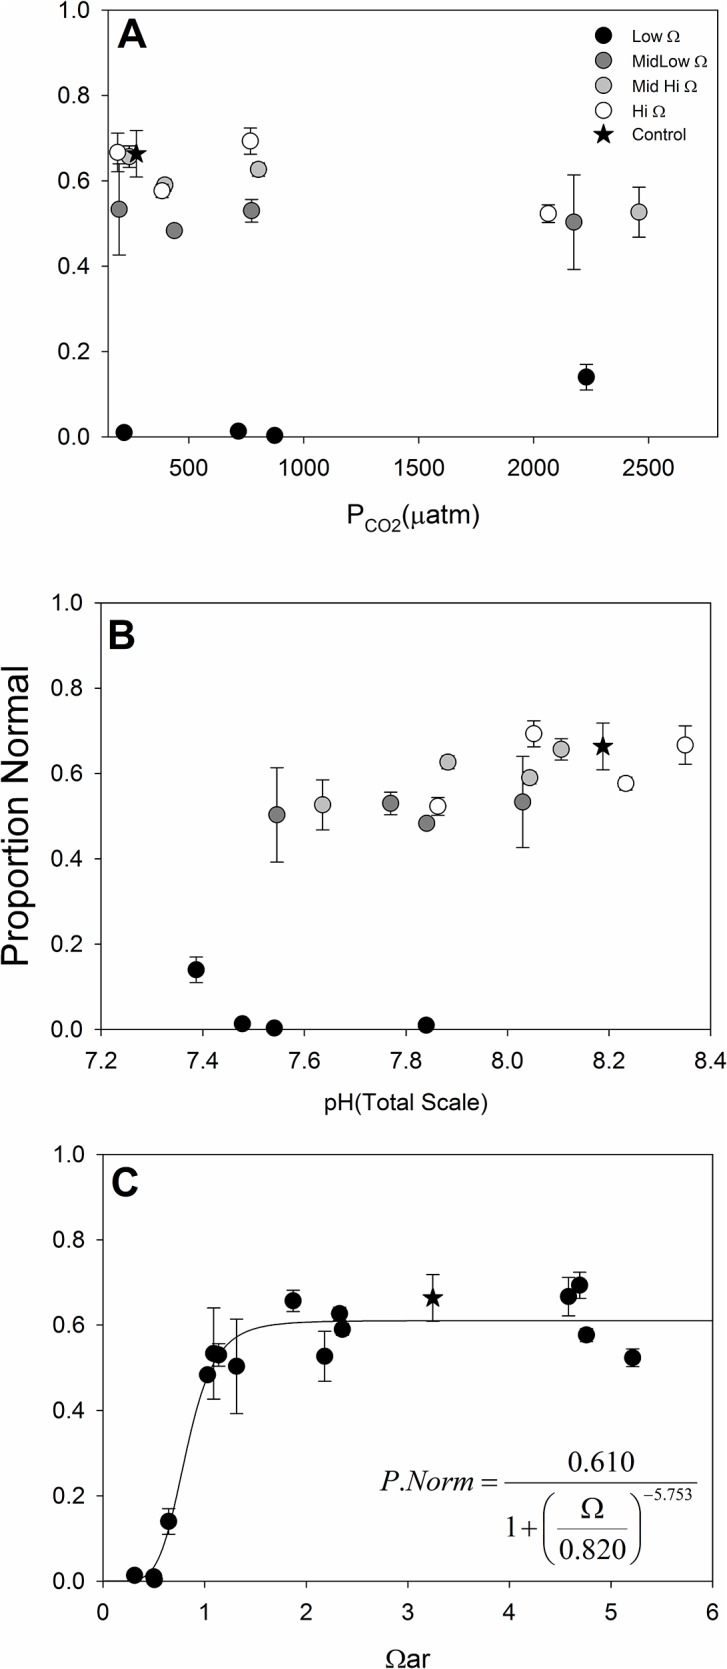
Proportion Normal Shell Development.The proportion of normally developed shells in relation to (A) PCO2, (B) pH, and (C) Ωaragonite. Greyscale symbols denote Ωar treatments in panels A and B, and the star is the control treatment. Error bars are standard deviations of the three replicate BOD bottles per treatment. See text for fit of model noted on panel C.